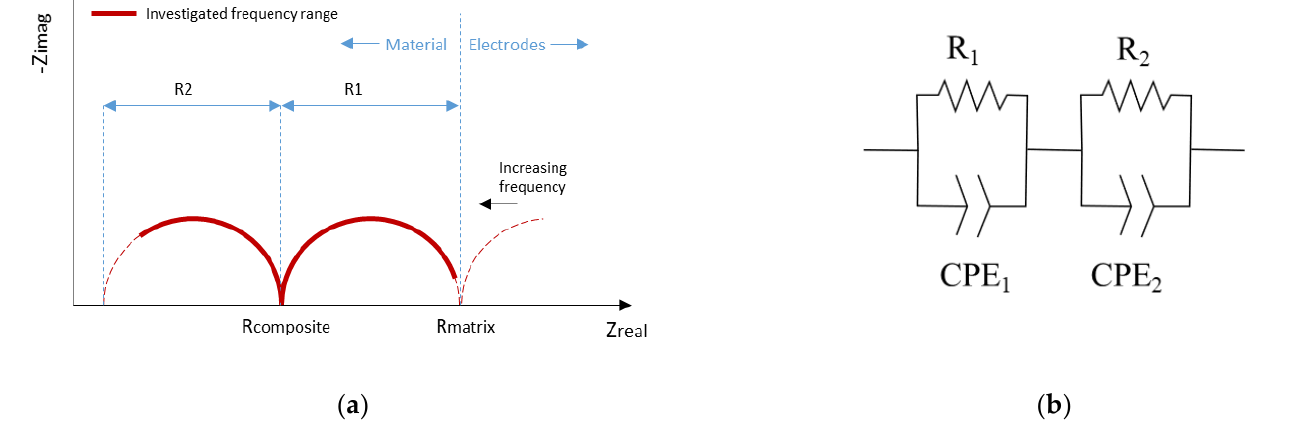
Figure 2. ( a ) Conceptual Nyquist representation of typical EIS data of cement-based composites incorporating electrically conductive short fibers and ( b ) equivalent circuit.